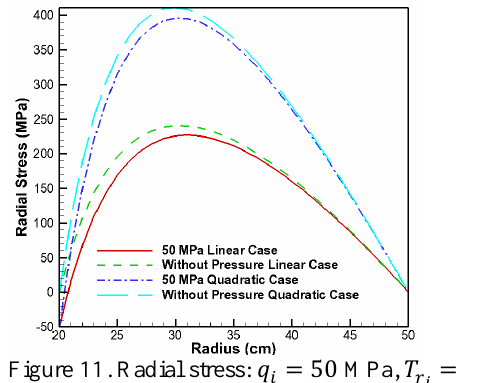
= 50 MPa, 𝑇 𝑖 = 250 𝑜 𝐶 and 𝜔 = 350 𝑟 𝑜 rad/s